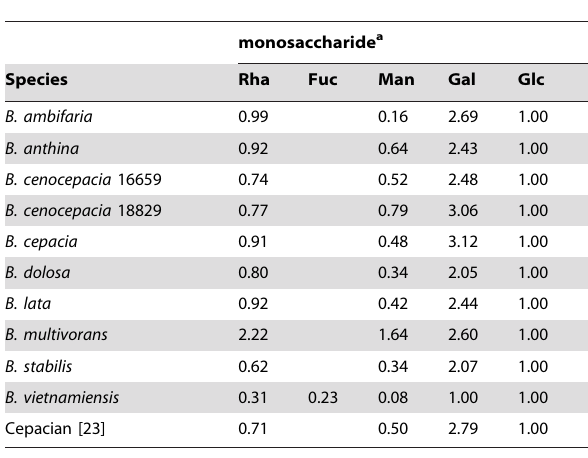
Table 2. Determination of neutral monosaccharides in the EPOLs of different BCC bacterial isolates and comparison with literature data for CEP [23].